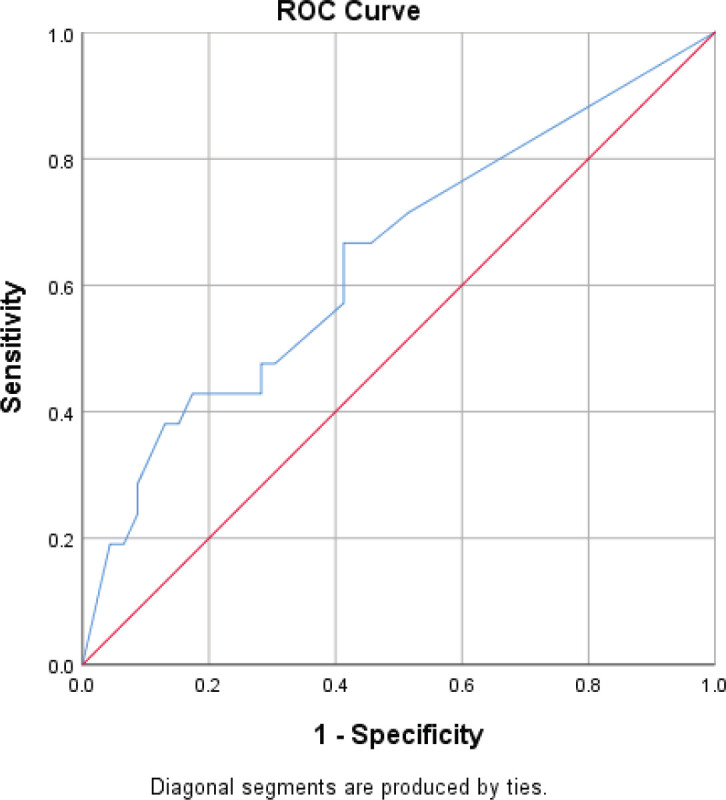
ROC curve for predicting survival using proportion of metastatic lymph nodes.